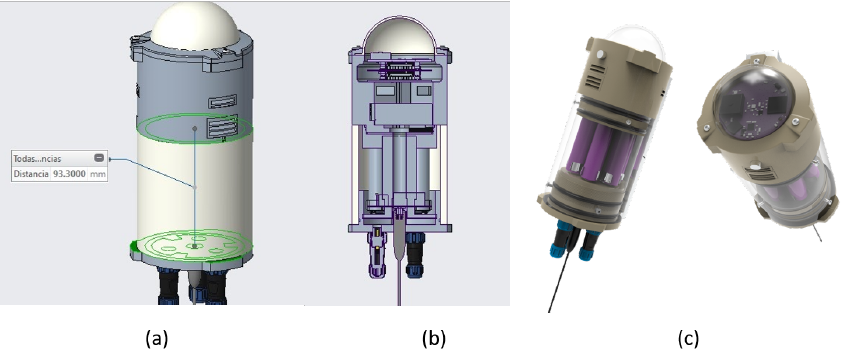
Figure 9. ( a ) The case developed for the measurement device, ( b ) Transversal cut to see the inside disposition of the elements and the different chambers specially designed to orientate the air mass flux through the payload bay where the gas sensors are located, and ( c ) Render visualization of the case to appreciate the translucid top dome and the lateral airflow